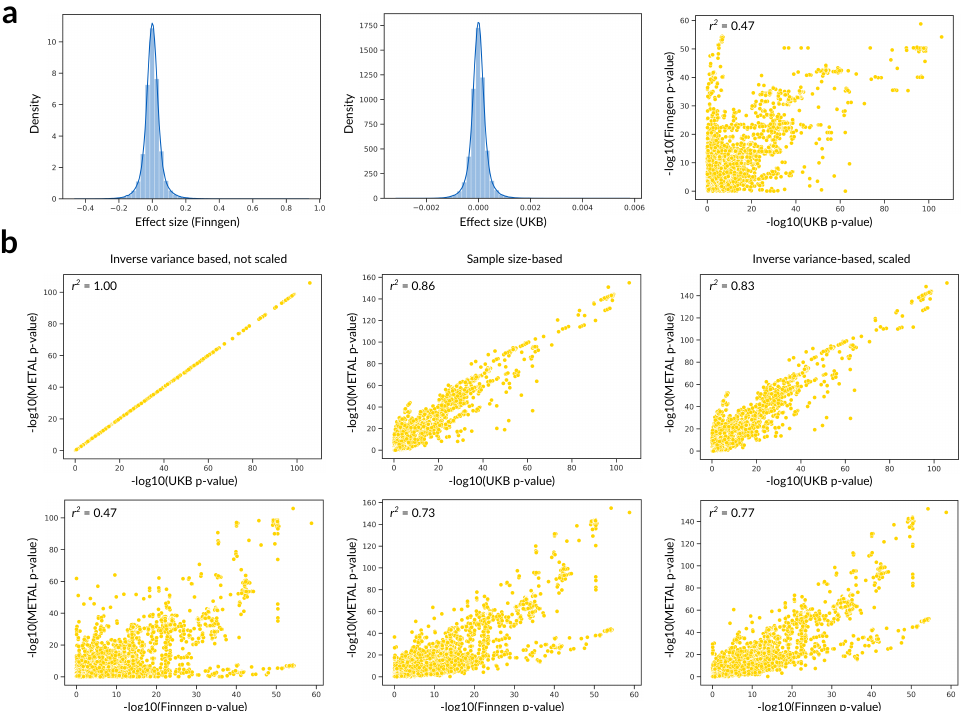
Figure 2. Bias in meta-analysis due to differences in data preprocessing. ( a ) Descriptive statistics of the raw data. Shown are (from left to right) effect size distribution in FinnGen, effect size distribution in UKB, and a scatterplot of p -values from UKB and FinnGen. ( b ) Scatterplot showing a comparison of METAL meta-analysis p -values for (from left to right) inverse variance method using raw data, sample size-based method, and inverse variance method using scaled data (scaling was performed by multiplying UKB effect size by the ratio of mean effect size from FinnGen to UKB). Note the extremely high degree of correlation of meta-analysis p-values and UKB p -values in case of inverse variance test and original UKB effects. Phenotypes used for analysis: other (seronegative) rheumatoid arthritis, wide (RHEUMA_OTHER_WIDE) from FinnGen, and other rheumatoid arthritis (M06) from UKB. Data and code used for the analysis presented in this figure are publicly available in the repository at https://github.com/TohaRhymes/meta-analysis-methods-comp, accessed on 27 November